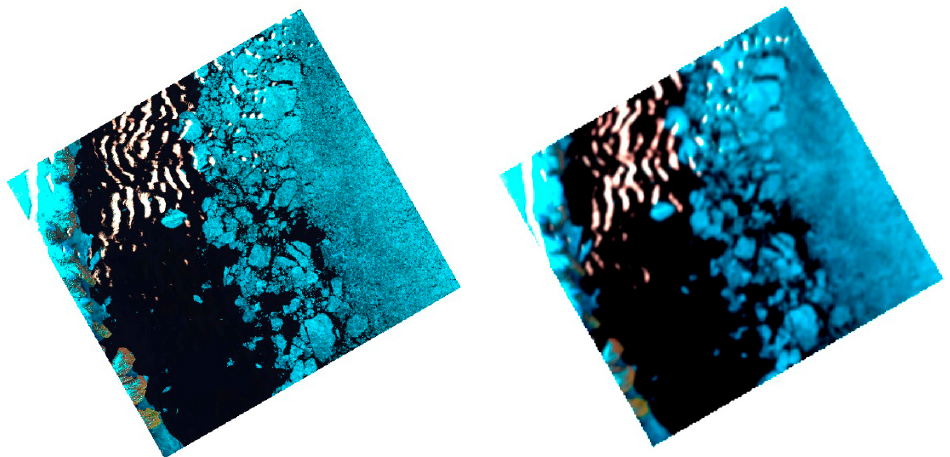
Figure 2. ( left ) Natural-color RGB image combination of Landsat 8 Operational Land Imager (OLI) band 5 (1.6 μ m, red component), band 4 (0.86 μ m, green component) and band 3 (0.64 μ m,